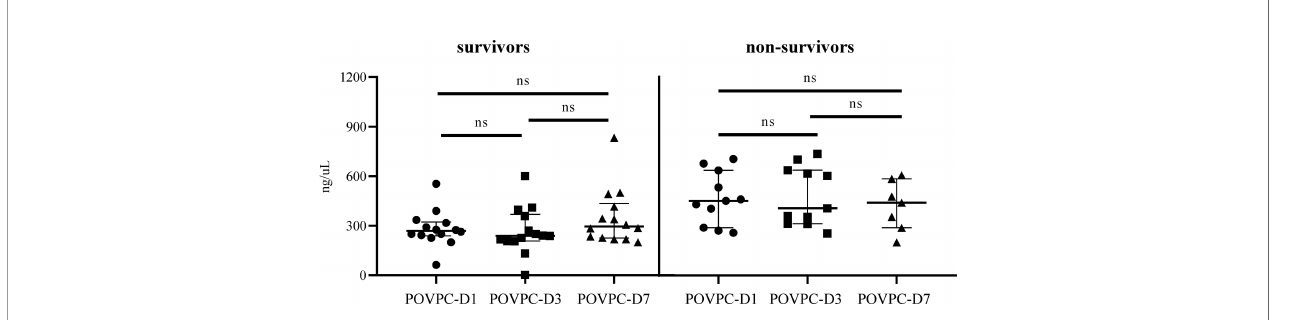
FIGURE 3 | The difference in HDL POVPC of septic survivors and non-survivors at different time points. The difference in HDL POVPC of septic survivors and non- survivors at Day 1, Day 3, and Day 7. POVPC, 1-palmitoyl-2- (5-oxovaleroyl)-sn-glycero-phosphatidylcholine; D1, Day 1; D3, Day 3; D7, Day 7; ns, not signi fi